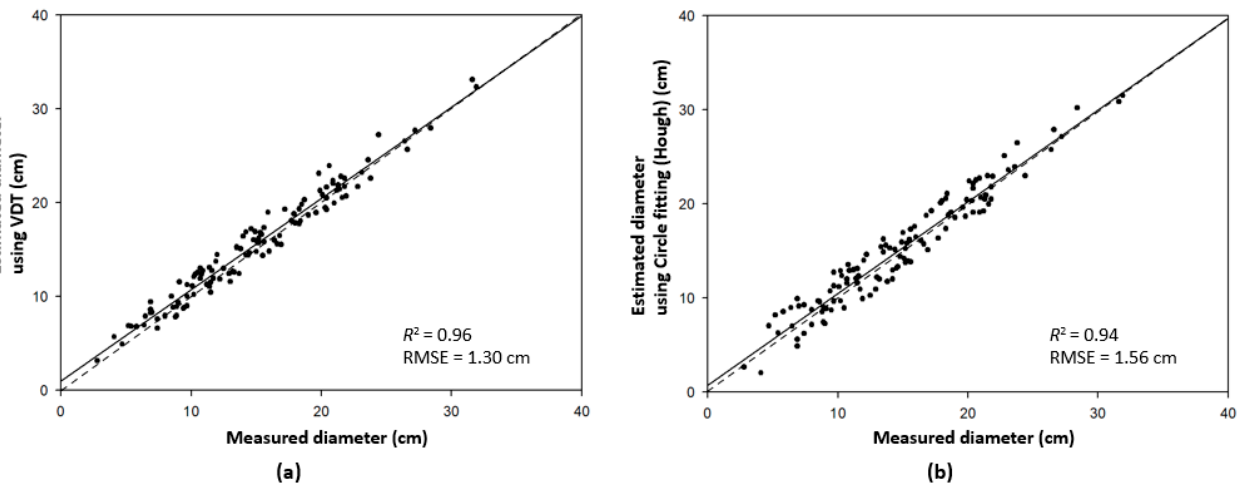
Figure 8. The results of VDT estimations of stem diameter at an arbitrary height along a tree bole: ( a ) VDT measurement; ( b ) cylinder fitting (Hough) method. In the figure, VDT refers to virtual diameter tape; R 2 refers to the coefficient of determination; RMSE refers to the root mean square error.